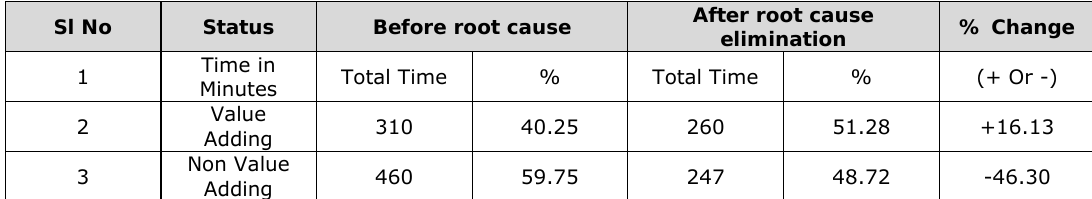
Table 9. “Comparison of results of pivot